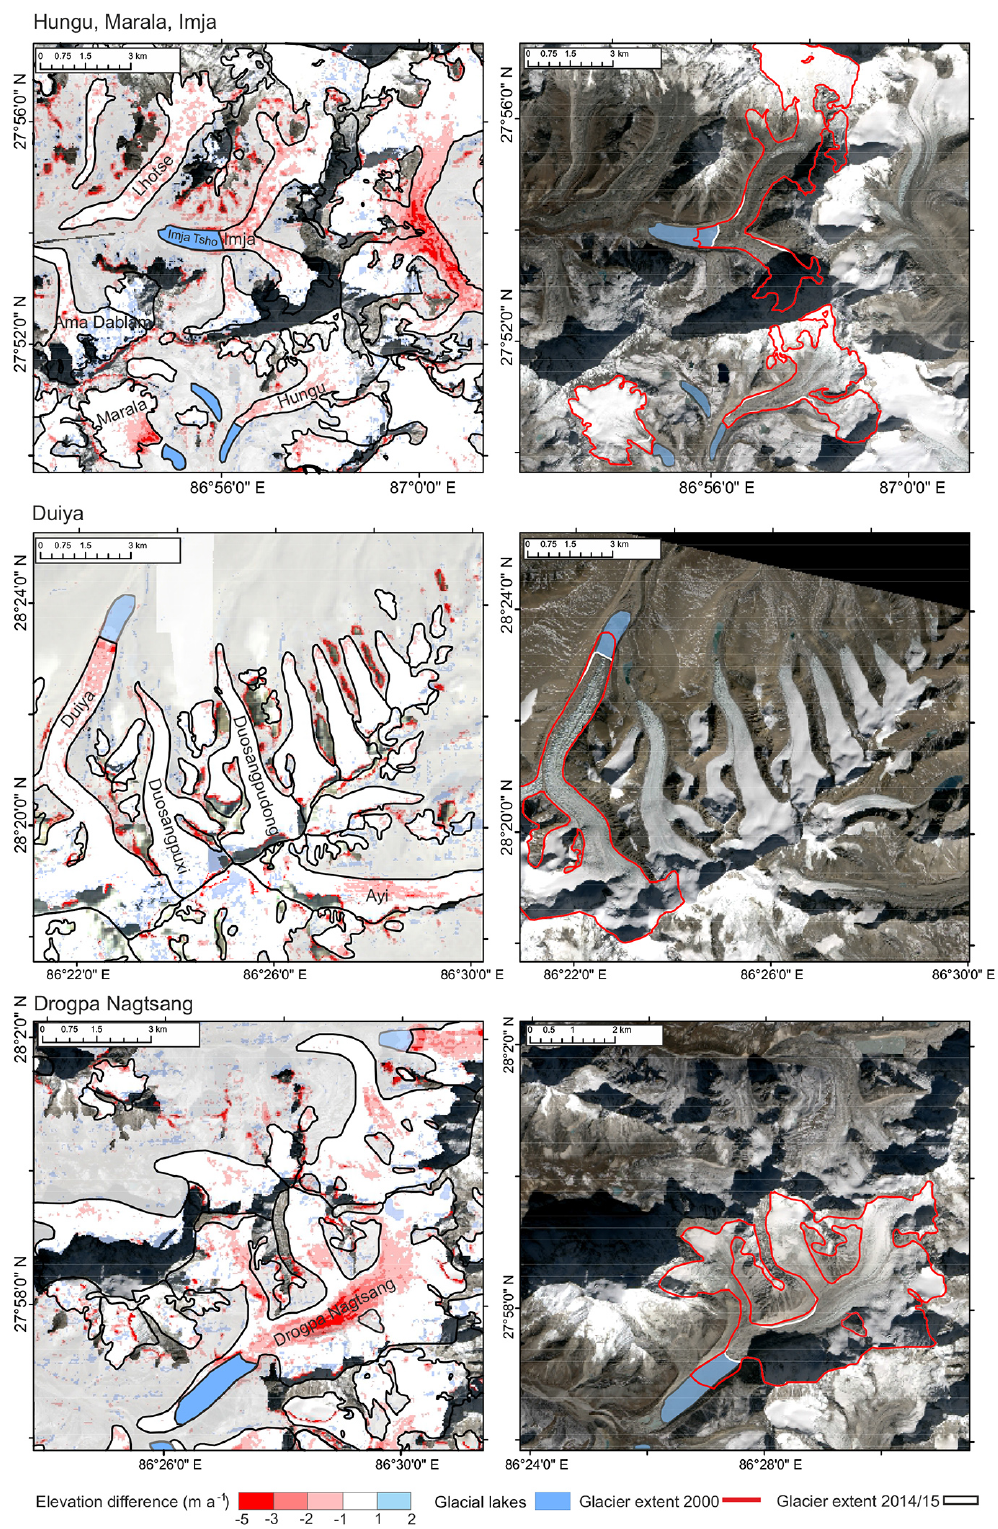
Figure 4. Further examples of glacier surface elevation change and total area change over the study period on lacustrine-terminating glaciers. Semi-transparent, off-glacier differences are also